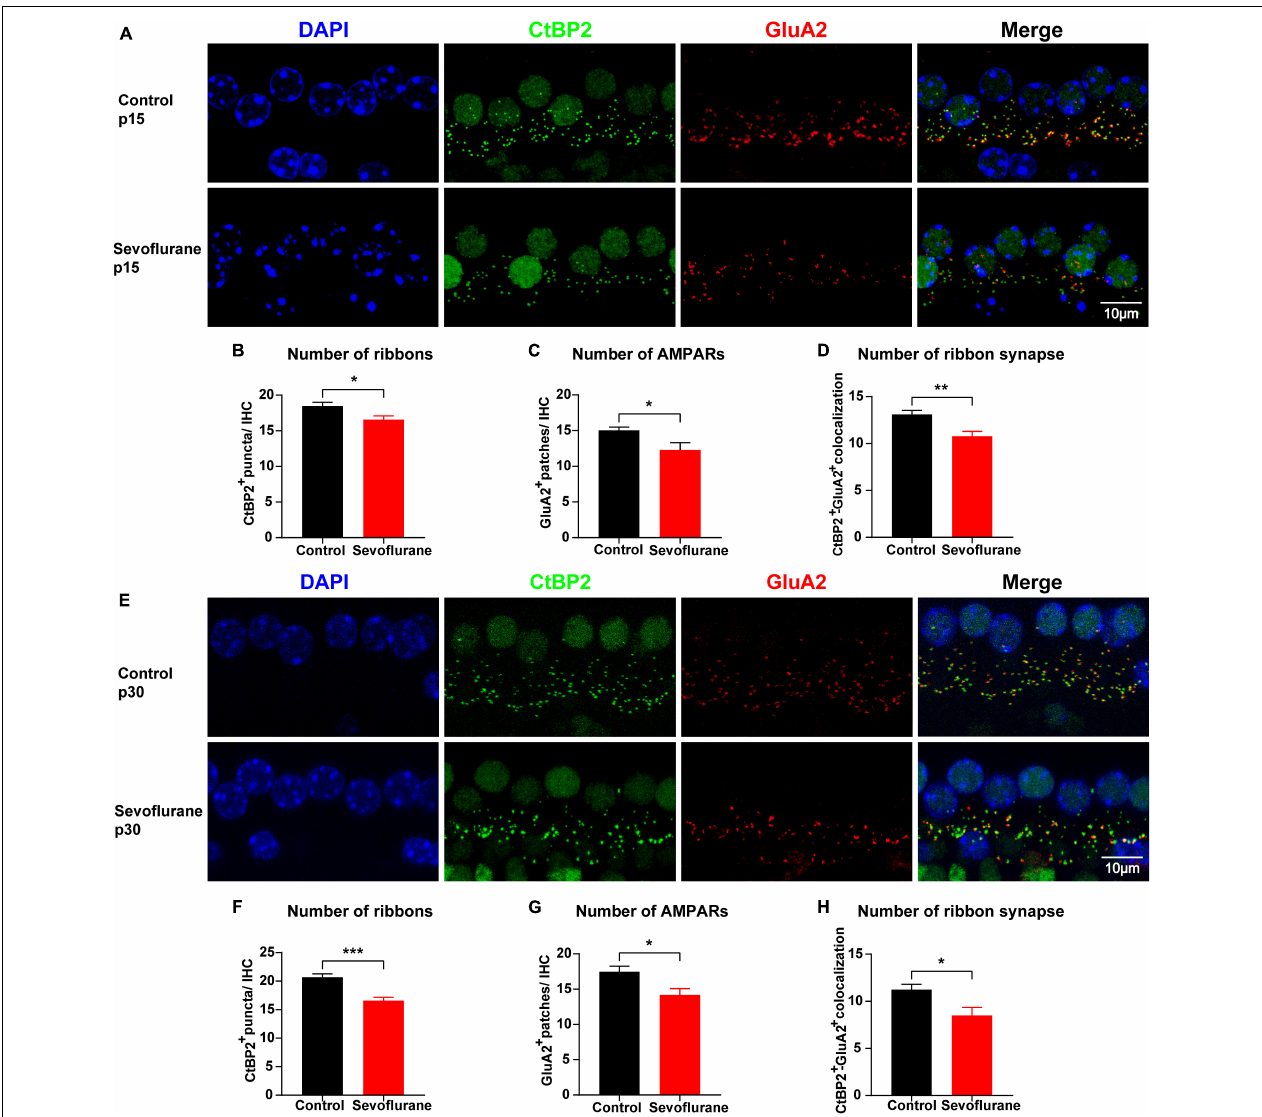
FIGURE 3 | Multiple sevoflurane exposures in naïve mice cause ribbon synapse loss. (A,E) Pre-synaptic ribbon and post-synaptic AMPA receptors (AMPARs) labeled with CtBP2 (green) and GluA2 (red), respectively. Nuclei are labeled with DAPI (blue). After multiple sevoflurane exposures in naïve mice, ribbons, and AMPARs degenerated on P15 and P30. (B–D) The number of CtBP2-positive ribbons, GluA2-positive AMPAR, and ribbon synapses decreased on P15. (E) Ribbon synapse loss persisted on P30. (F–H) The number of CtBP2-positive ribbons, GluA2-positive AMPARs, and the ribbon synapse number decreased on P30 ( n = 8 control group, n = 8–9 sevoflurane group). * P < 0.05, ** P < 0.01, *** P < 0.001, unpaired Student’s t -test. Scale bar = 10 µ